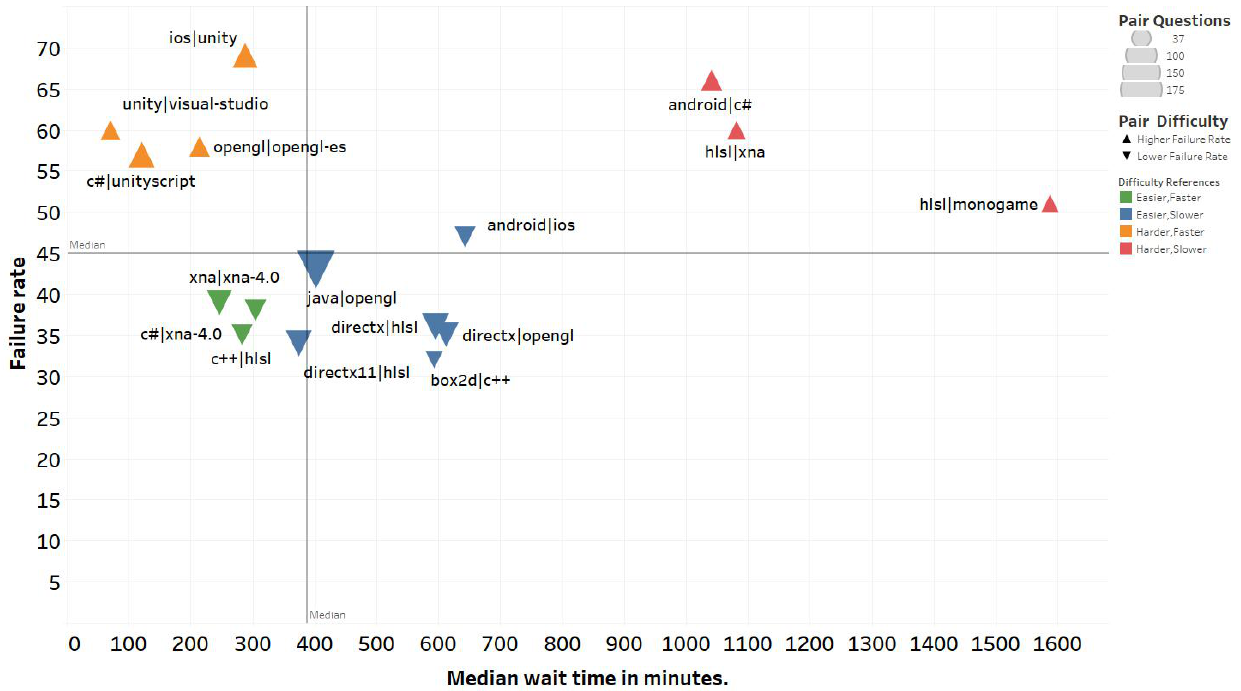
Figure 8. Community support for Tech | Tech pairs. Upwards (resp. downwards) triangles indicate cases where the pair has a failure rate at least 5 points higher (resp. lower) than any of its constituents. The size of the triangles is indicative of the number of questions for the tag pair. Colors indicate the relative support of the pair in the set of tech tech